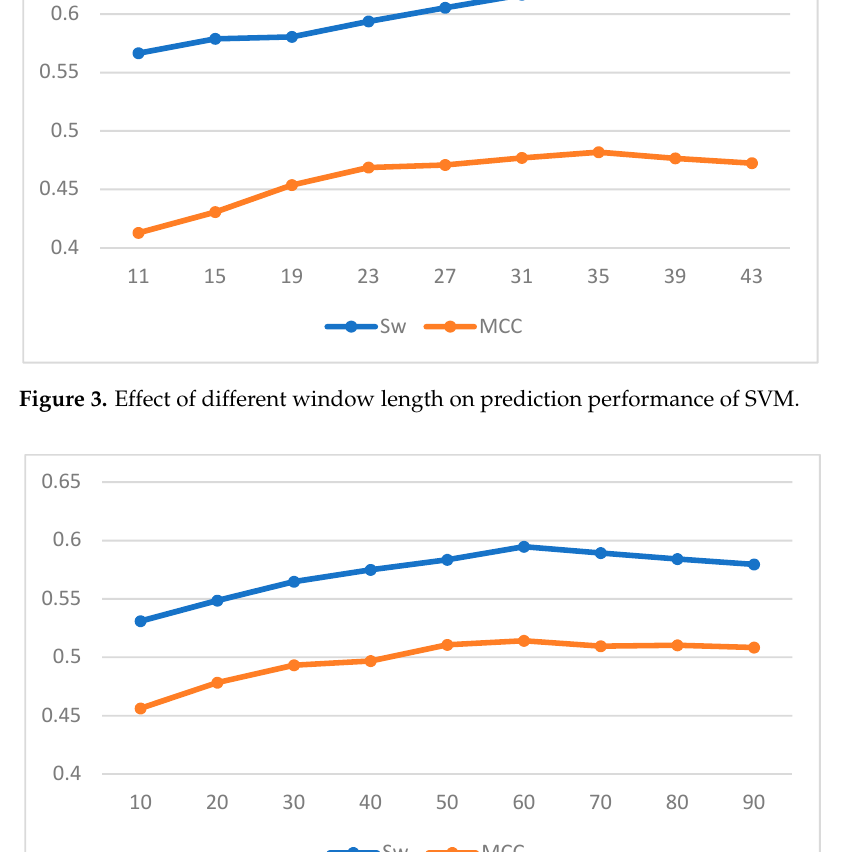
Figure 4. Effect of different window length on prediction performance of BP neural network.